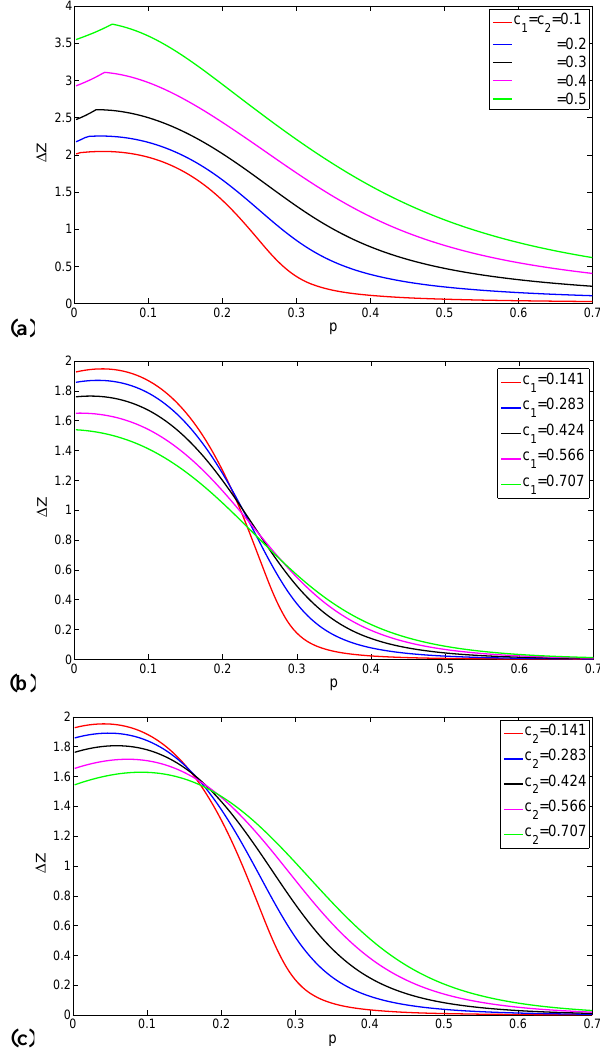
Fig. 3. Effect of the relative initial sideband amplitude on the mod- ulation depth for ε = 0 . 2 and θ = 0 . 7 π : (a) c 1 = c 2 ; (b) initial low frequency sideband amplitude c 3 = 0; (c) initial high frequency sideband amplitude c 2 =